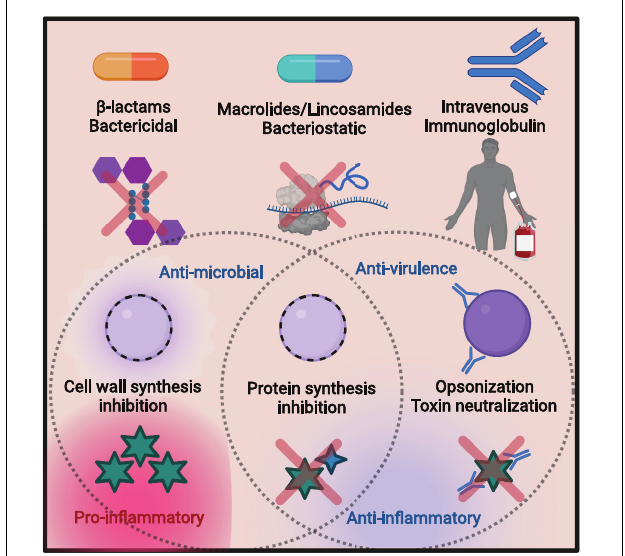
FIGURE 1 | Summary of the treatment methods discussed in this review. Bactericidal β -lactams such as penicillin target the peptidoglycan of the cell wall, leading to cell lysis. This can lead to an efflux of virulence factors and other cellular proteins, resulting in inflammation. Macrolides and lincosamides are bacteriostatic, blocking protein synthesis by targeting the bacterial ribosome. Preventing toxin synthesis works to reduce inflammation. Intravenous immunoglobulin (IVIG) is an infusion of pooled antibodies from human donors, which works to induce opsonization and neutralize toxins, reducing inflammation. Figure made in